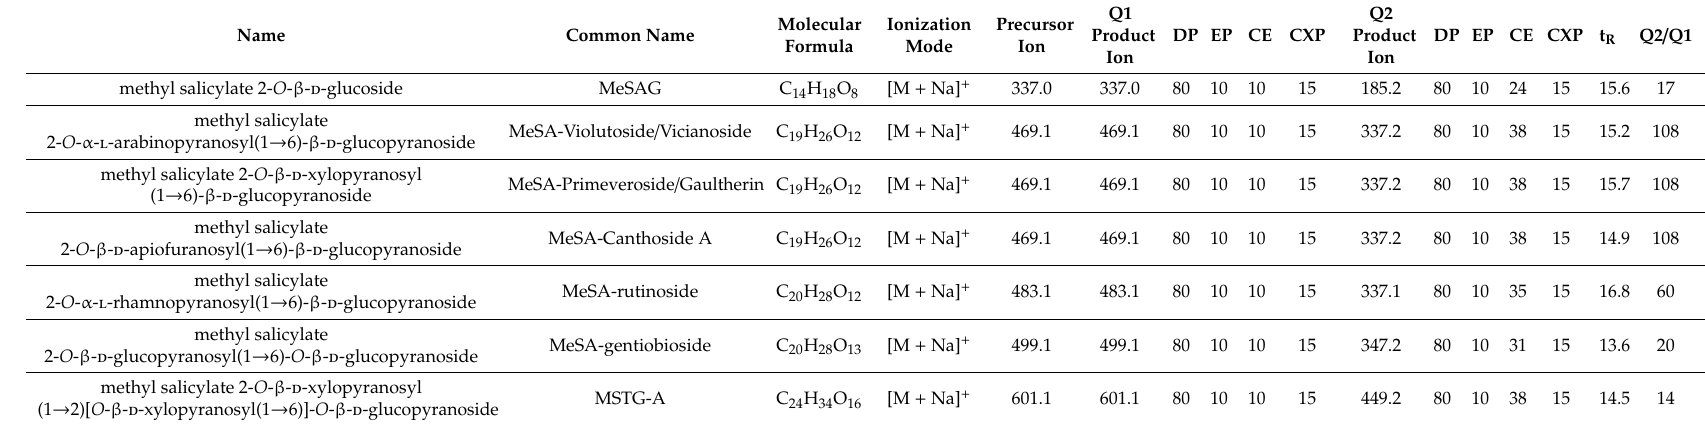
Table 3. Chemical name, common name, molecular formula and instrument parameters for the LC-MS / MS quantification of di ff erent MeSA glycosides.